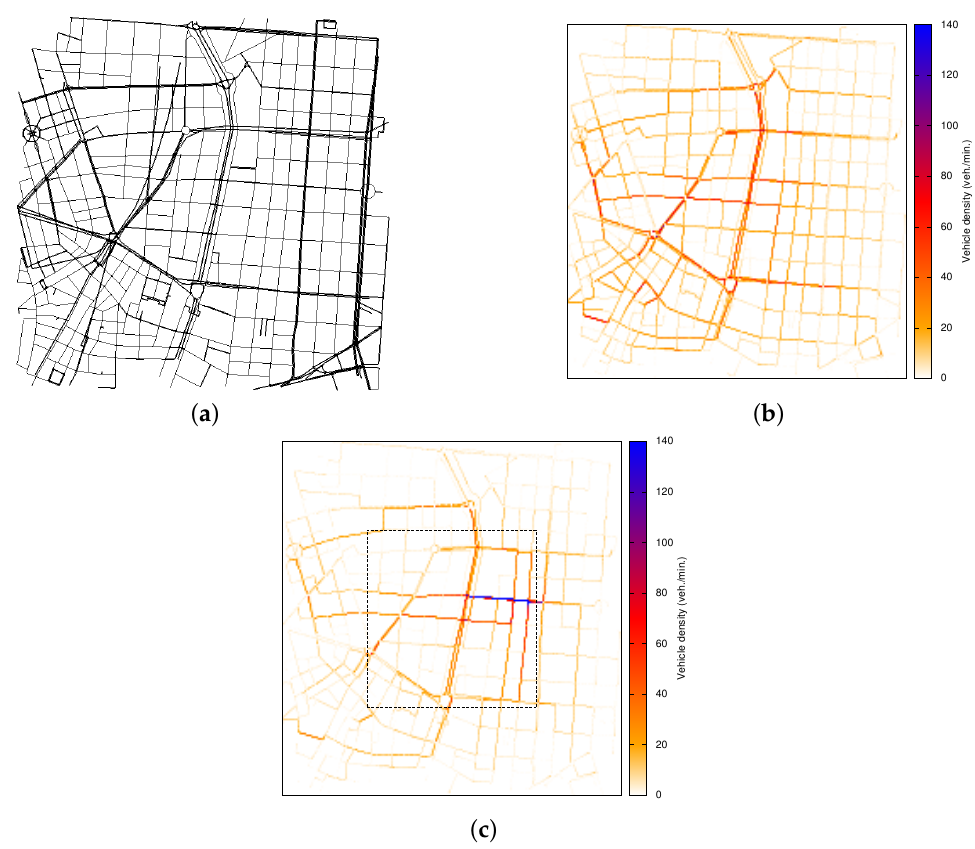
Figure 4. Scenario 1: City of Madrid, Spain. ( a ) Street map layout; ( b ) Krauss model: vehicular density for each street; ( c ) downtown model: vehicular density for each street in the downtown (square